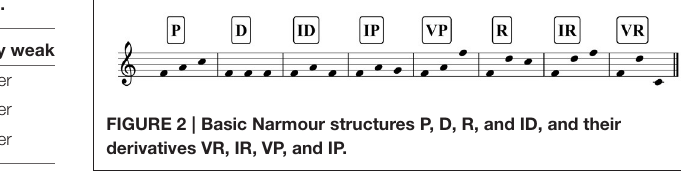
verylarge if ds n ≥ 1.6 s 